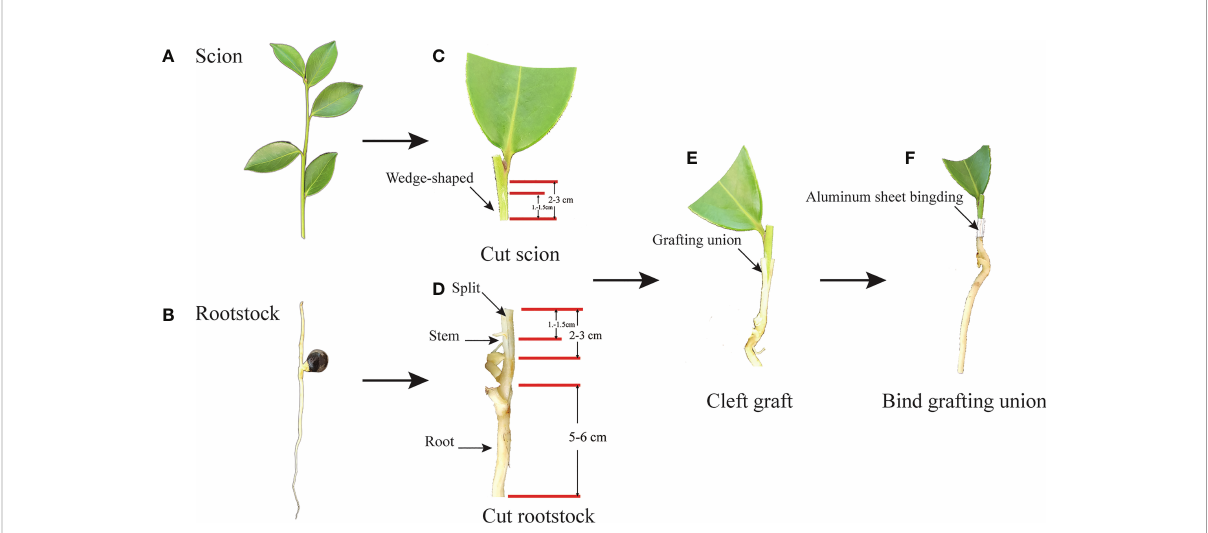
FIGURE 1 The process of nurse seedling grafting. (A) Scion: semi-wooden scion. (B) Rootstock: un ligni fi ed seedling rootstock of half-sib seed. (C) Cut scion: Cut semi-wooden scion (2-3cm long) from the same trees as rootstock seeds, and cut length in 1.2-1.5cm with wedge-shaped and meet pith. Then cut half the leaves of the scion. (D) Cut rootstock: cutting 2-3 cm from the stem of the seedling, and Split about 1.0-1.5 cm in the middle of the stem, and trim about 5-6 cm in the root of the rootstock. (E) Cleft grafting: the wedged-scion inserted into the split of rootstock. (F) Bind grafting union: fasten the aluminum sheet on the joint of the rootstock and the scion tightly